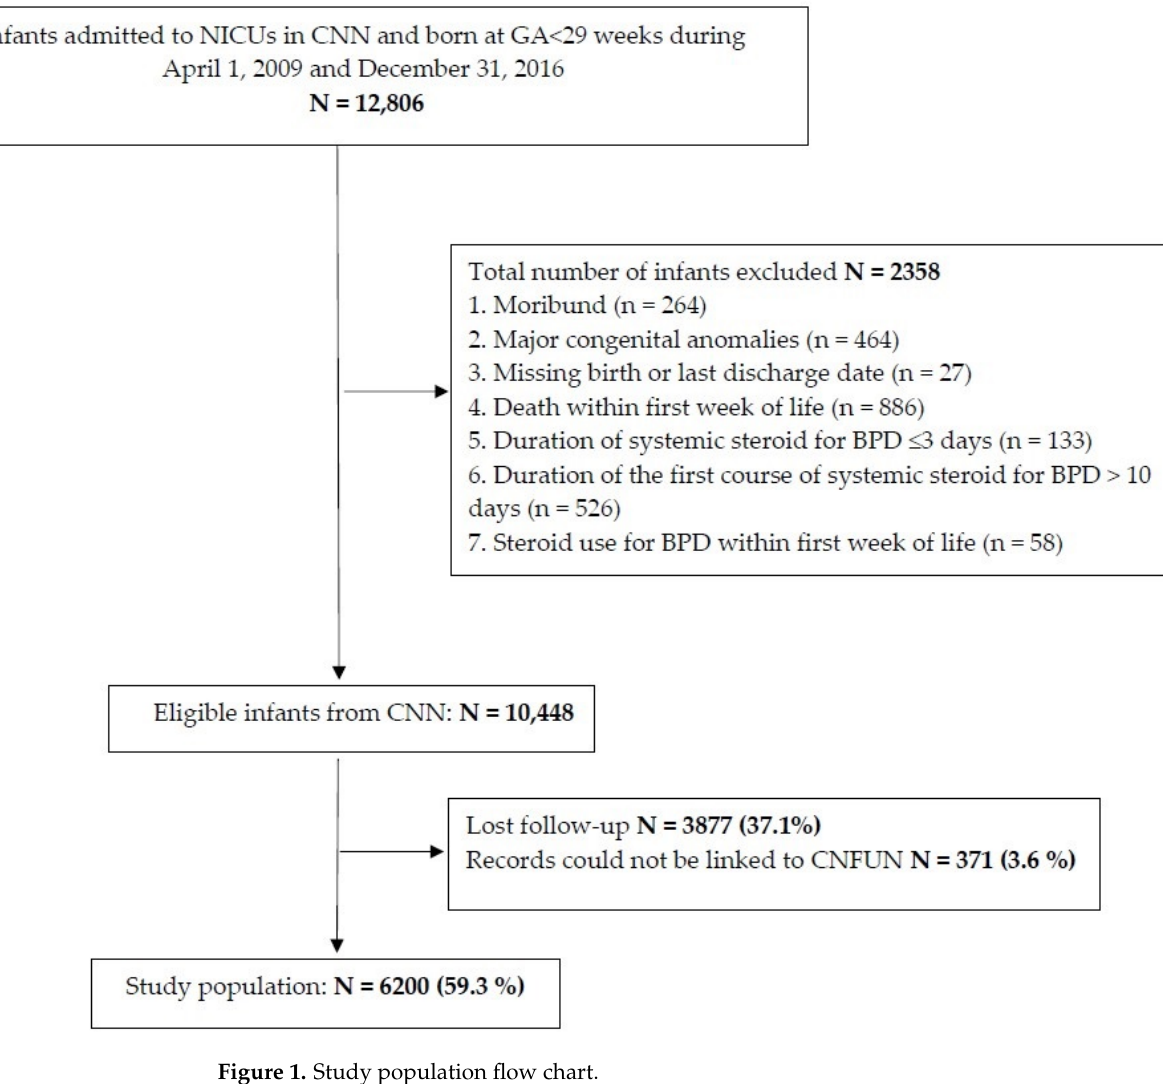
Figure 1. Study population flow chart.